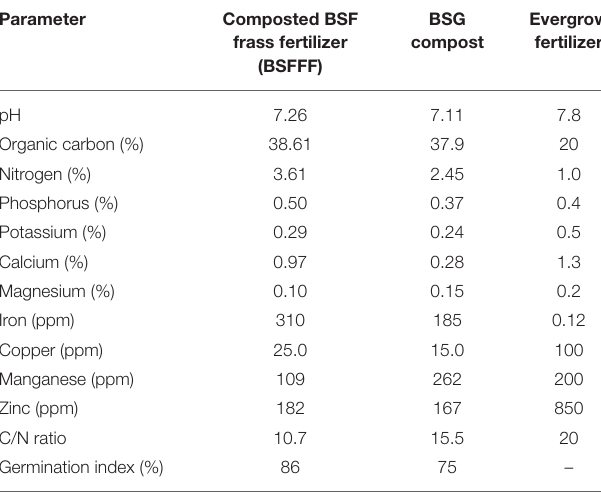
TABLE 2 | Characteristics of organic fertilizers used during